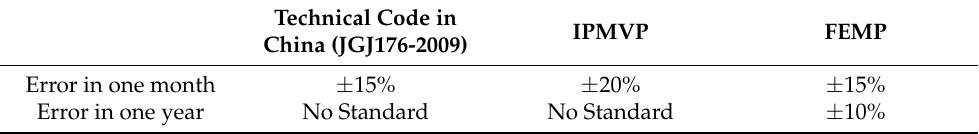
Table 7. Relevant international